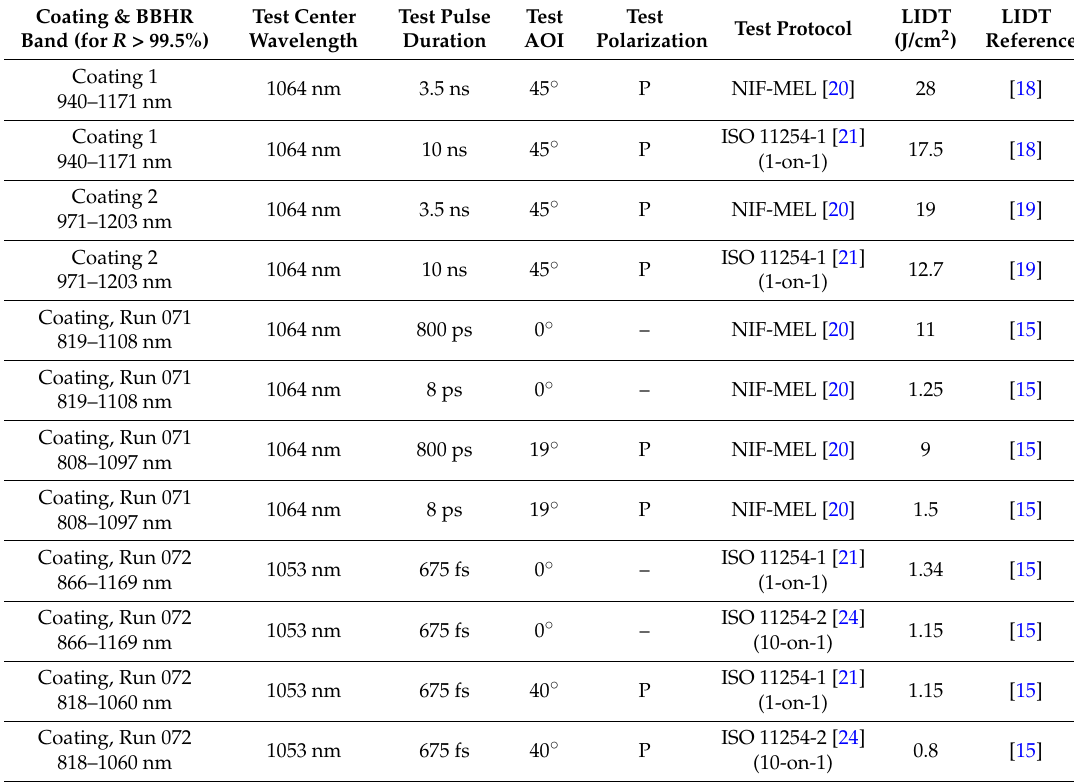
Table 5. LIDT test results for TiO 2 /SiO 2 BBHR